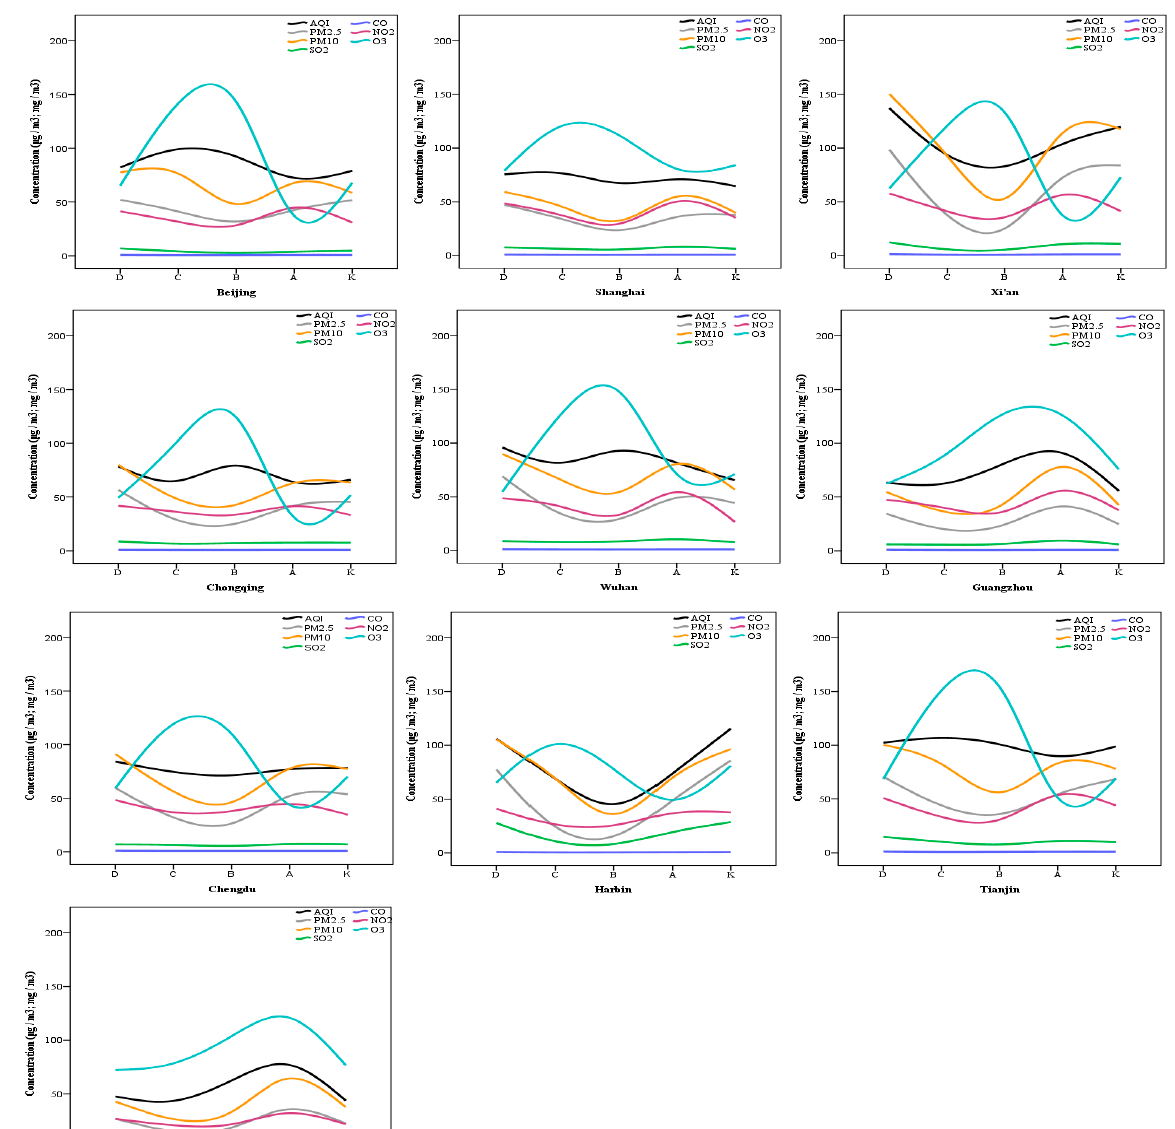
Figure 3. Graphical display of air pollution level in 10 major Chinese cities several months before and during the initial phase of the COVID-19 outbreak (lockdown period), highlighting the difference in air quality at different periods. A—1 month to 3 months before the outbreak (October 2019 to December 2019); B—3 months to 6 months before the outbreak (July 2019